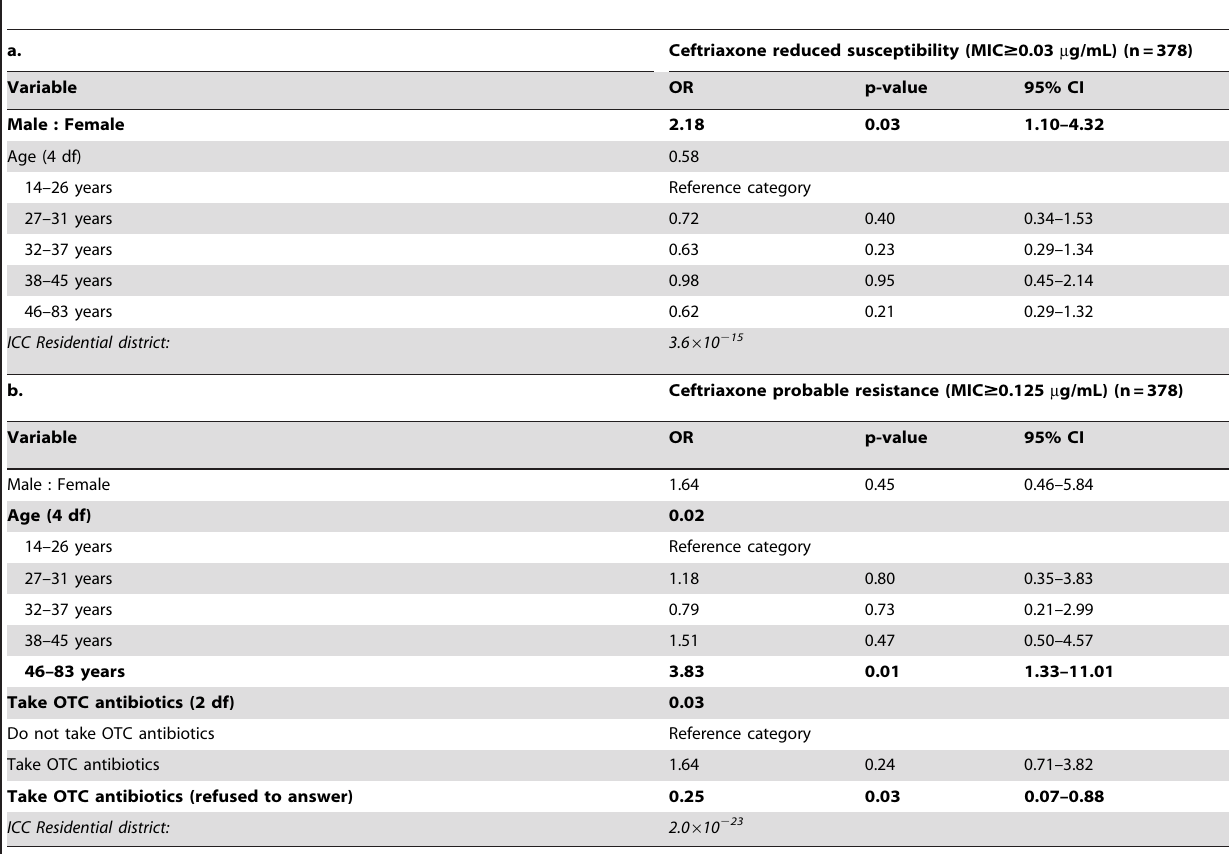
Table 4. Results of multivariable analysis for reduced susceptibility and probable resistance to ceftriaxone (odds ratios (OR) and 95% confidence intervals (95% CI)).